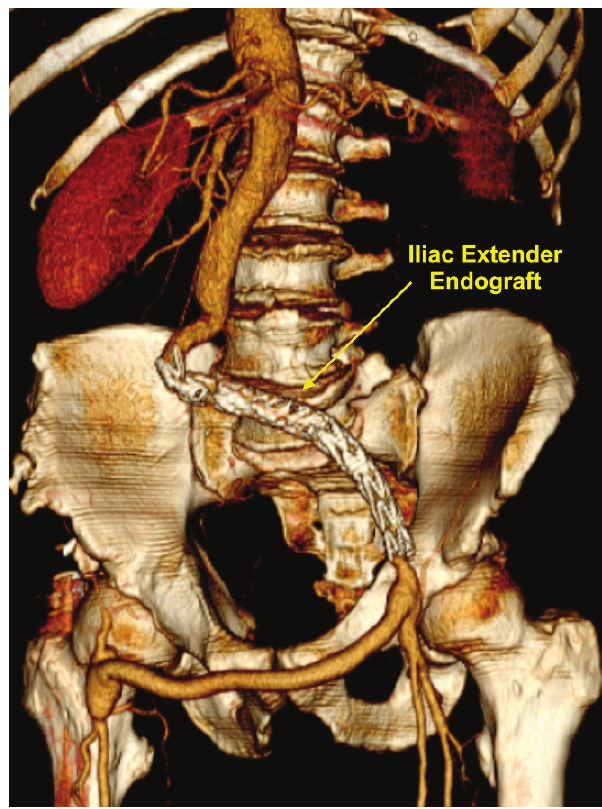
Figure 3 - Postoperative contrast-enhanced computed tomogra- phy angiography reconstruction, showing complete resolution of the arteriovenous fistula